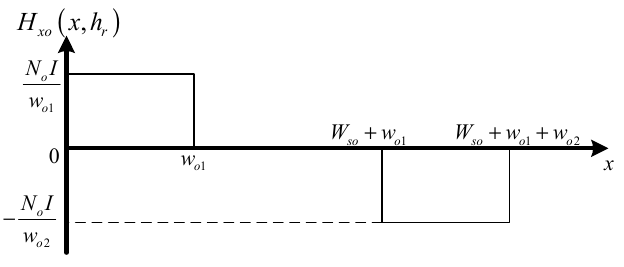
Figure 11. Expression of magnetic field intensity ( ) ,